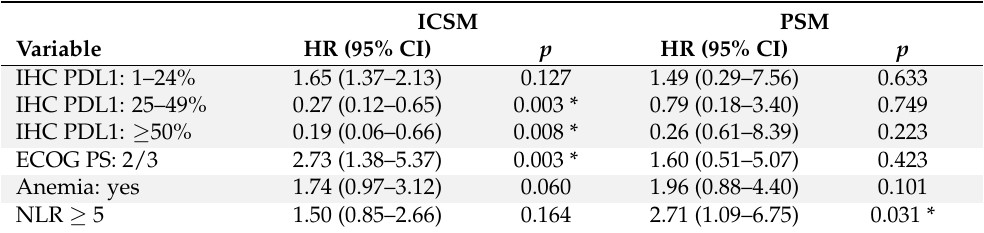
Table 3. Results from multivariate Cox proportional hazard regression model for time to progression